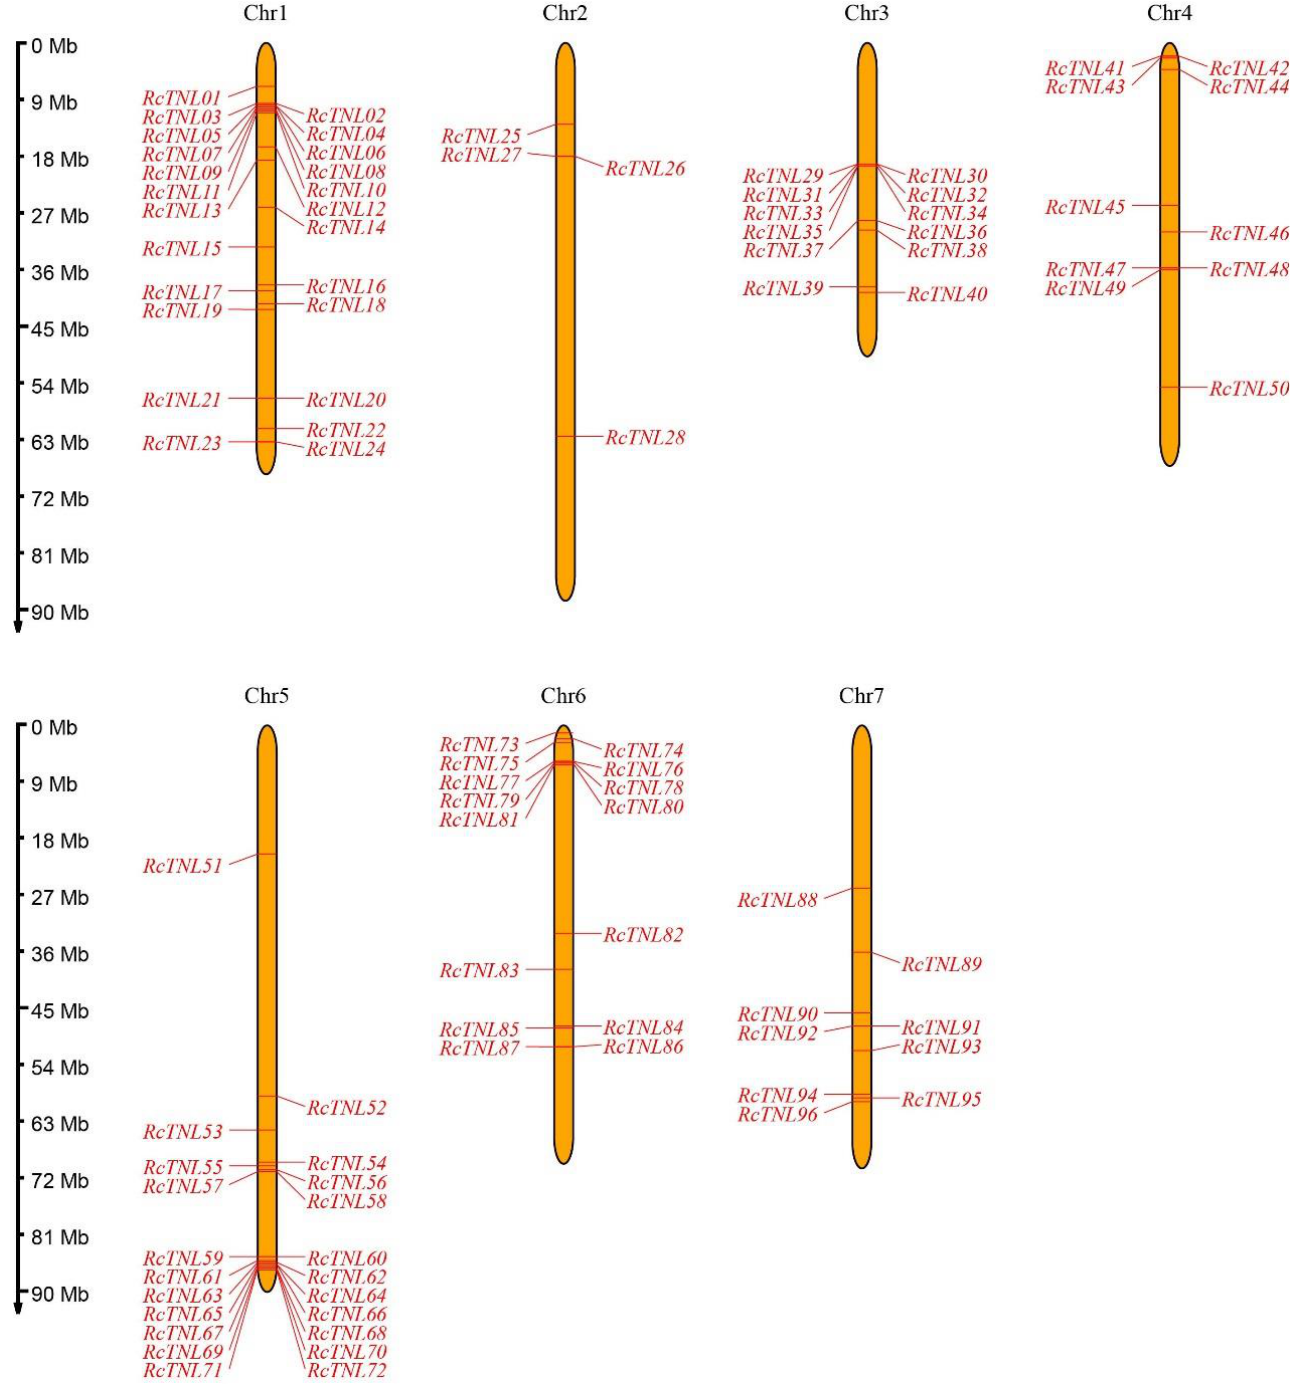
Figure 1. Distribution of TNL genes on Rosa chinensis ( R. chinensis ) chromosomes. The rulers on the left indicate the physical size of each chromosome; the ruler unit is megabase (Mb) pair. The black text across the top represents the chromosome number.